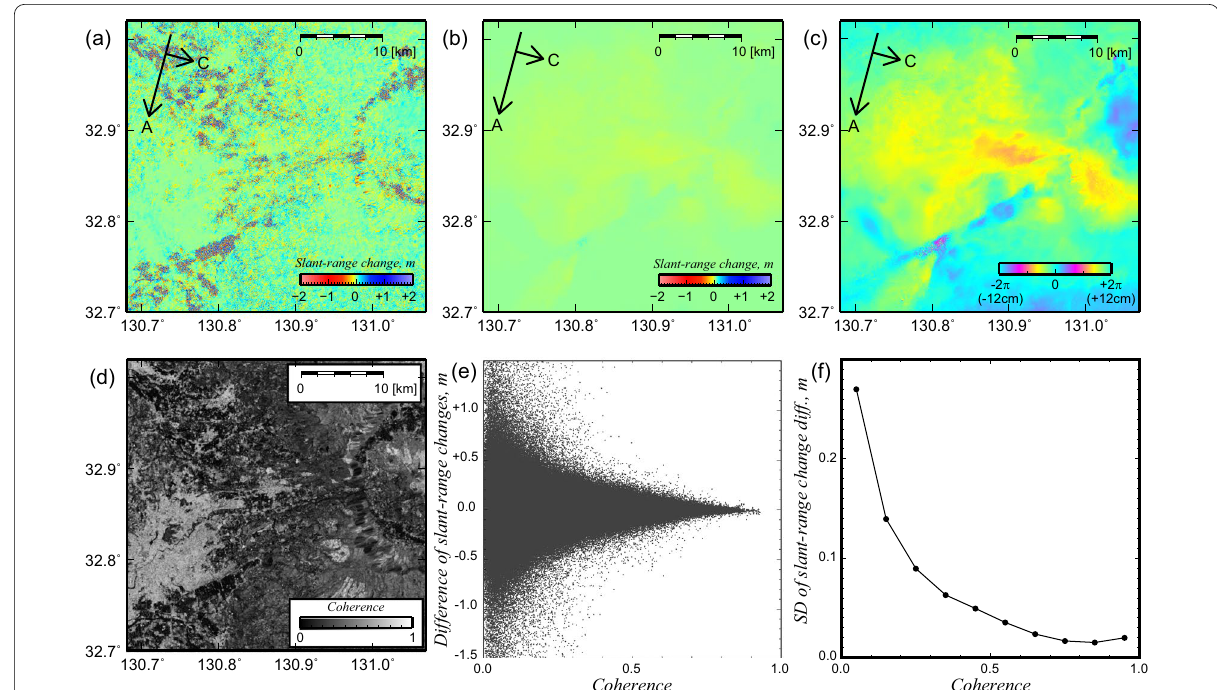
Fig. 5 a , b Slant-range change maps of the post-seismic pair of Path 126 obtained using the difference of split-band interferograms (DSI) analysis and conventional Interferometric Synthetic Aperture Radar (InSAR), respectively. c , d Differential interferogram and coherence obtained from conventional InSAR. e Scatter plot showing the differences in slant-range changes obtained using DSI ( y -axis) versus coherences ( x -axis). f Relationship between the coherence and standard deviation of the differences in the slant-range